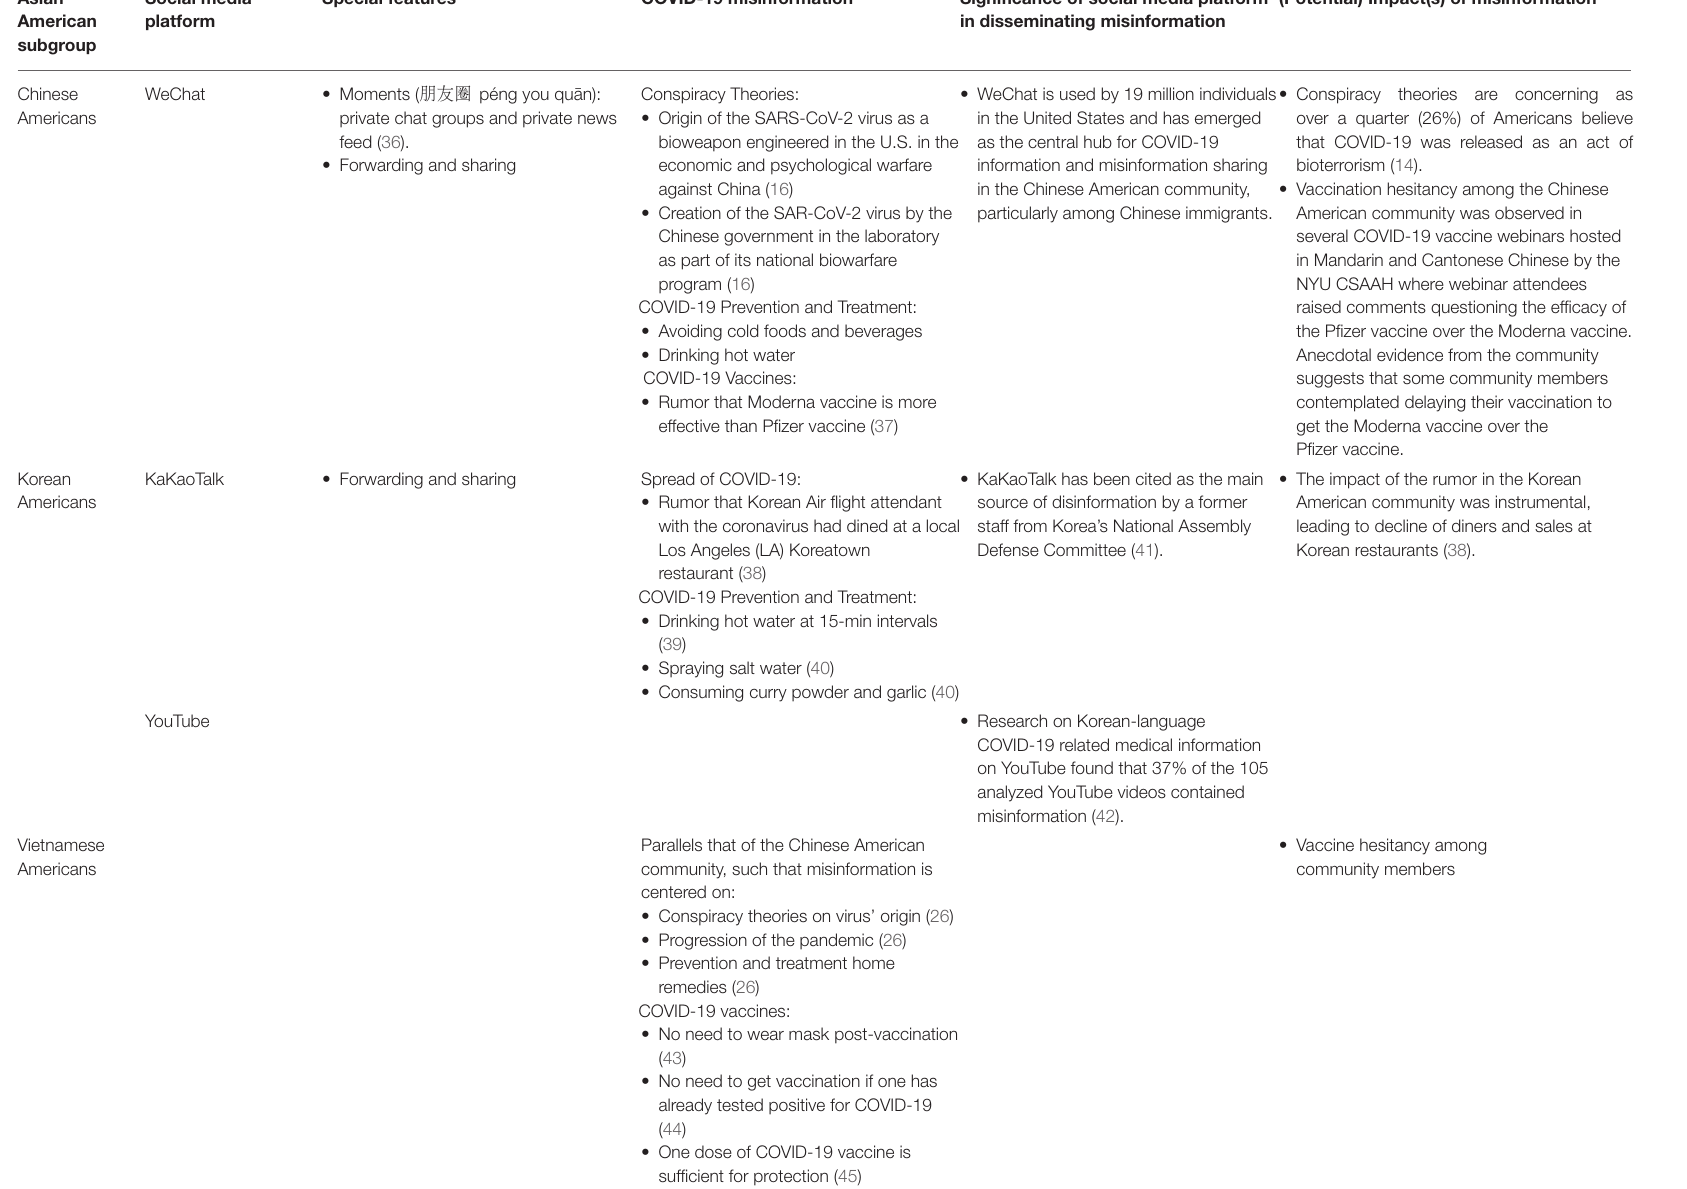
TABLE 2 | COVID-19 misinformation on social media platforms by Asian American